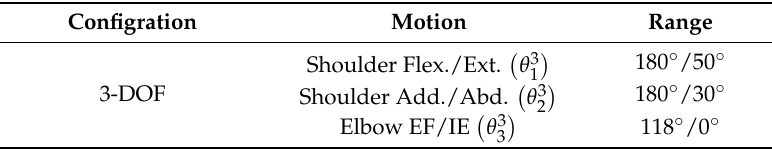
Table 4. Motion range of the 3-DOF upper-limb